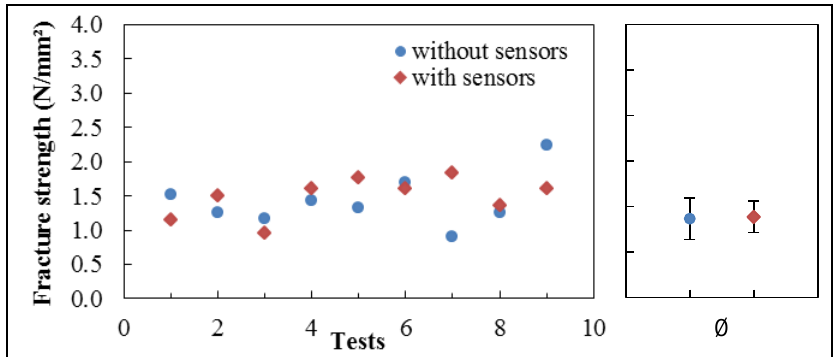
Figure 9. Comparison of the tensile testing results of the dog-bone test specimens with and without integrated